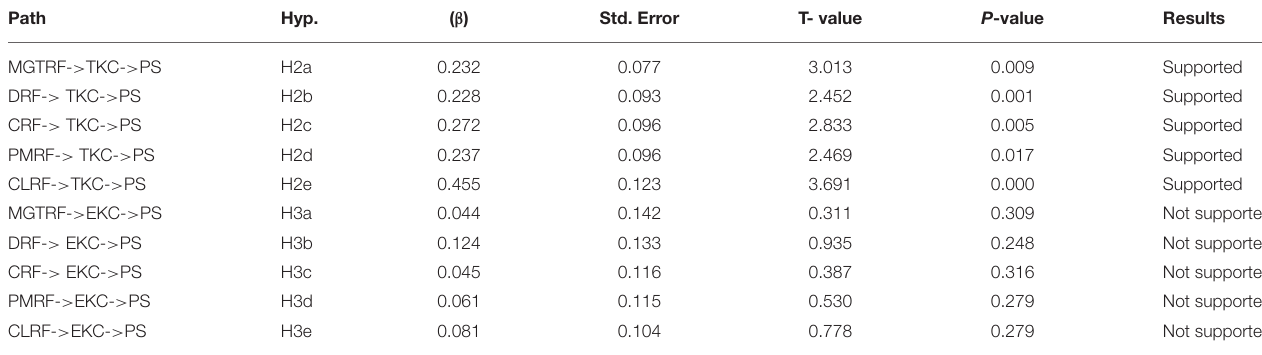
TABLE 13 | Mediating analysis (tacit and explicit knowledge creation) (result after boostrapping). Path